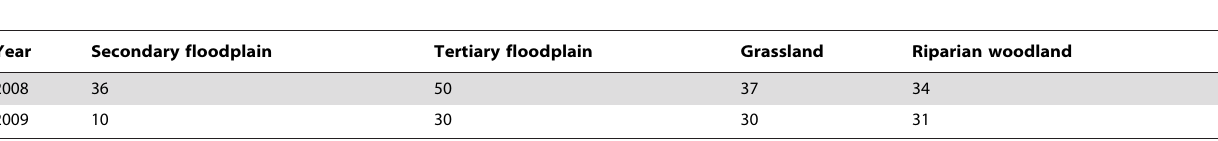
Table 7. Number of sites sampled for biomass in the four habitats most utilised by buffalo during the 2008 and 2009 late flood